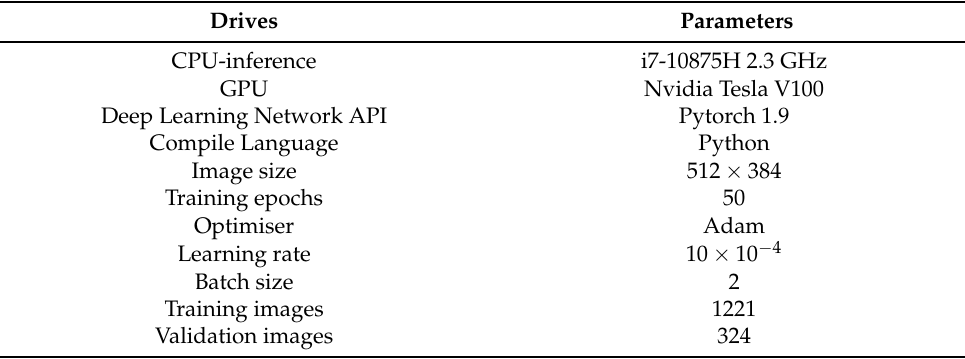
Table 1. Model parameter settings and hardware information.